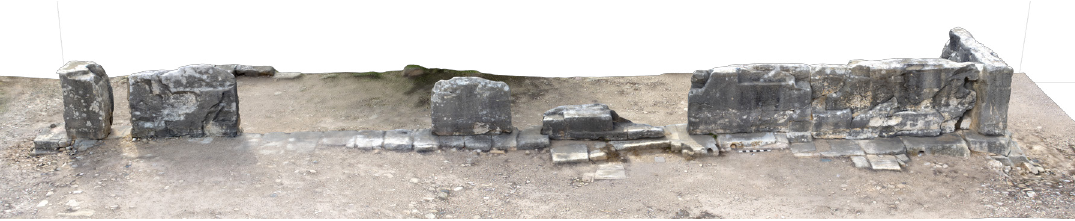
Figure 5. External west side of the surviving temenos megaliths (Sanctuary I). 3D by V. Tringas (PULP@). In the 1950s, three monuments of the Archaic and Classical periods were found at some distance from the temenos, on different plateaus. They are the rampart on Marchello , the palace on Hadjiabdoulla and the Classical peristyle house at Evreti (cf. Maier, 2004, pp. 59, 74, 77) (Fig. 6). Although all three received the short-term attention of the British Kouklia Expedition, they “were far from being fully excavated” (cf. Maier, 2004, pp. 34–35). In 1966, F.-G. Maier resumed fieldwork at Palaepaphos as director of the Swiss- German Expedition. In the next four decades, with an unparalleled attention to detail, he pulled